Question: Identify the chart type used in this figure.
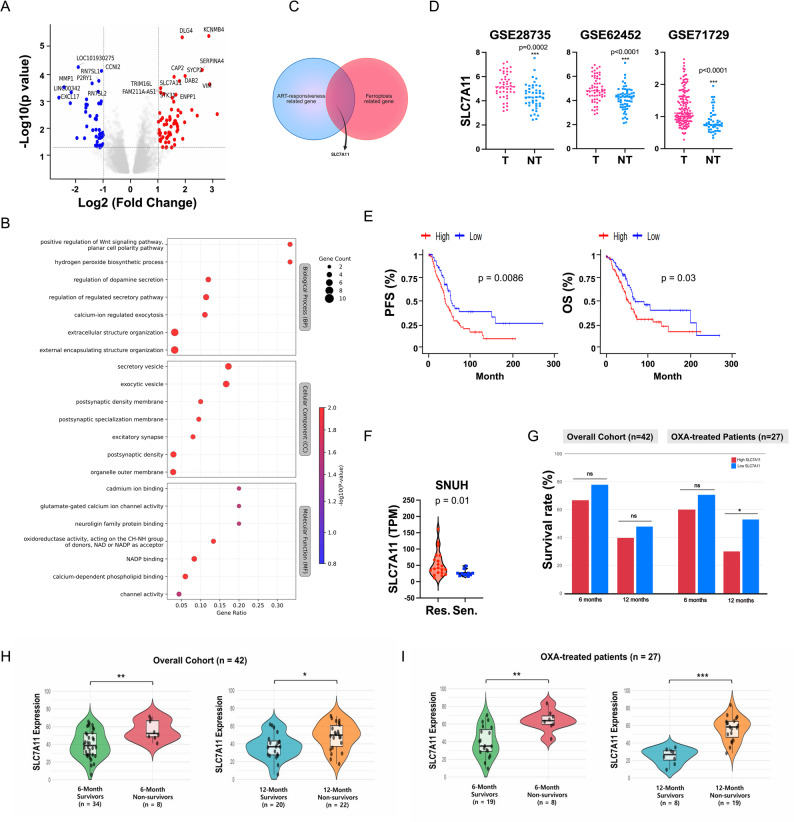
Answer: survival